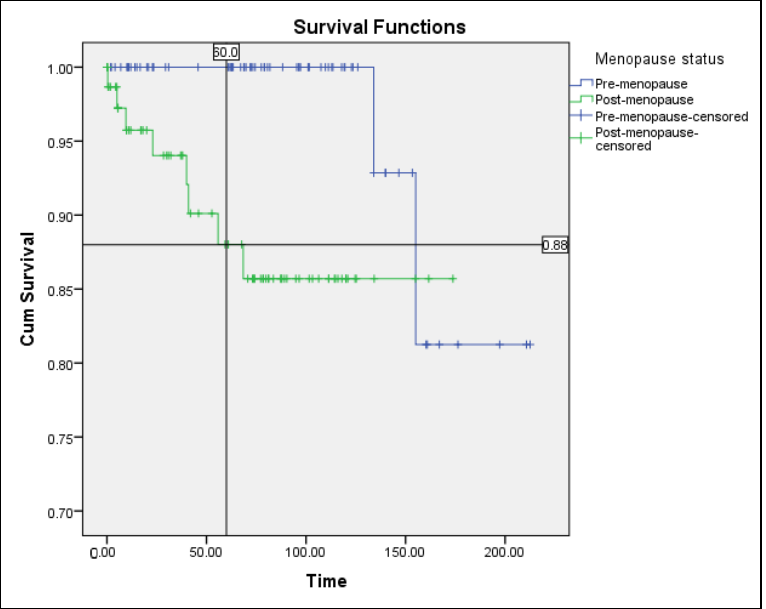
Figure 1. Survival curve (Kaplan – Meier method). Premenopausal group versus postmenopausal group. Overall survival among endometrial cancer patients in Hospital Melaka from 2002 – 2015.